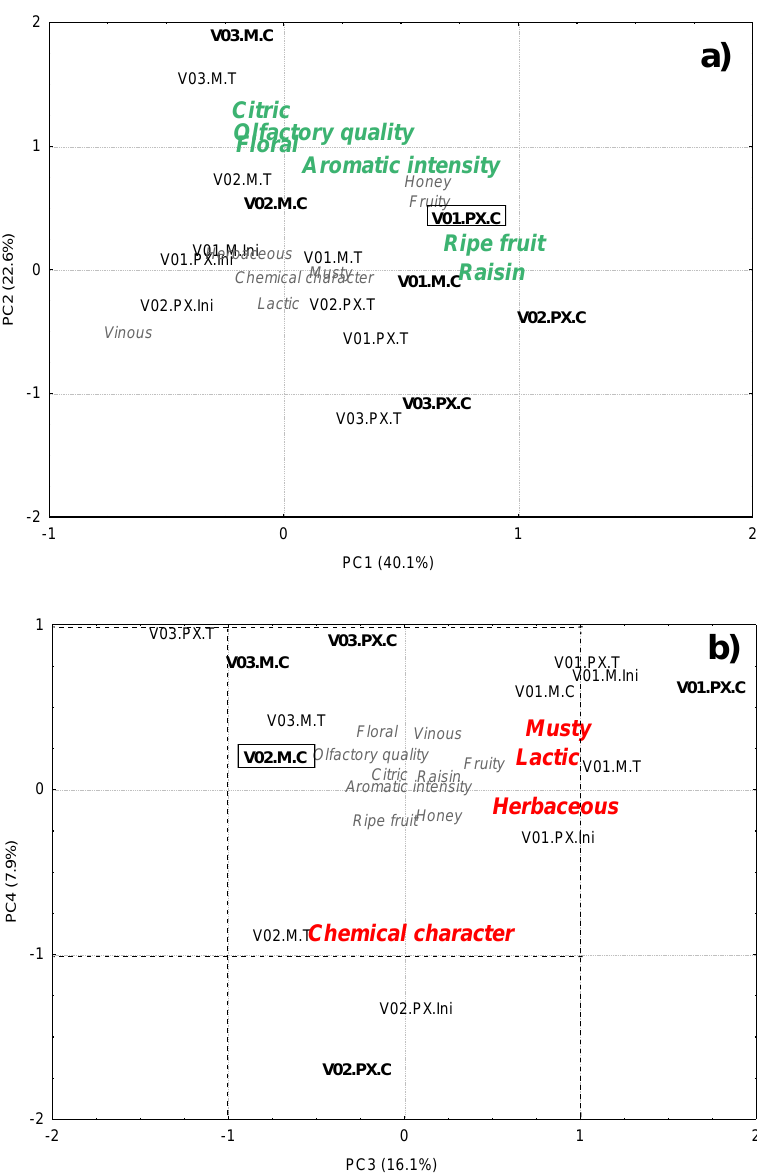
Figure 1. Principal components analysis of the sensory scores of musts from raisins obtained by the two different drying methods tested. Representation of both, the samples scores and the principal component loadings, onto the new space defined by: ( a ) PC1 and PC2 and ( b ) PC3 and PC4. The names of the samples indicate the vintage.variety.raisining method.